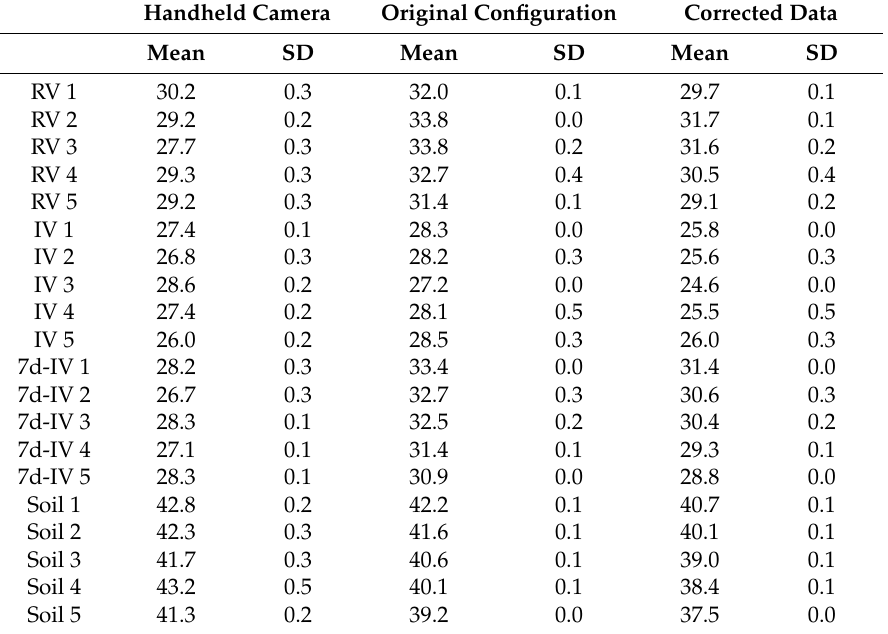
Table 6. Results obtained from the points sampled. Handheld